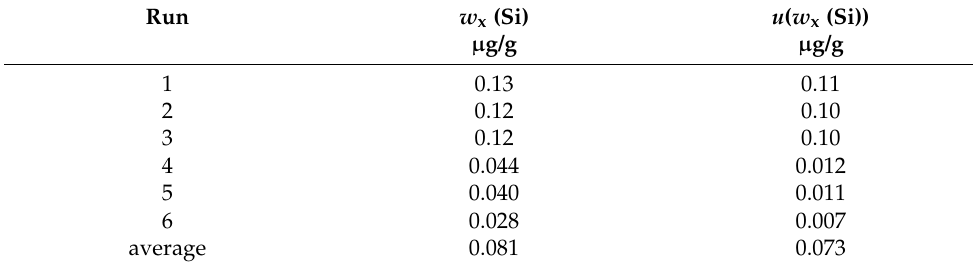
Figure 4. ( Left ): Mass fraction w x (Si) in TMAH aq . Error bars denote combined uncertainties ( k = 1). The red dashed line indicates the average value. ( Right ): Degrees of equivalence d i of the respective measurement results. Error bars indicate expanded uncertainties ( k = 2) associated with d i . All single results are consistent with the average value since the respective uncertainties encompass the red dashed zero line. Table 3. Mass fractions w x (Si) of silicon in TMAH aq and the associated uncertainties ( k =